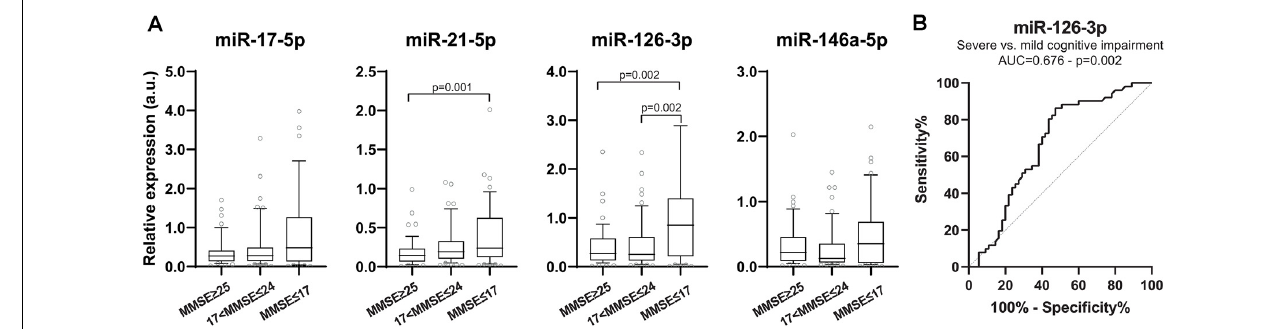
FIGURE 2 | Inflamma-miR levels in subjects are grouped according to Mini-Mental State Examination (MMSE) score. (A) Boxplots showing plasma miR-17-5p, miR-21-5p, miR-126-3p and miR-146a-5p levels in subjects with normal cognition (MMSE ≥ 25, n = 50), mild (18 ≤ MMSE ≤ 24, n = 52) and severe (MMSE ≤ 17, n = 55) cognitive impairment evaluated through MMSE score. Data are presented as a.u. of selected miRNA RE normalized with cel-miR-39. P -values for Kruskal–Wallis test with post hoc Dunn test. (B) ROC curve of miR-126-3p RE (a.u.) for discriminating between mild and severe cognitive impairment. AUC and corresponding p -value are reported.